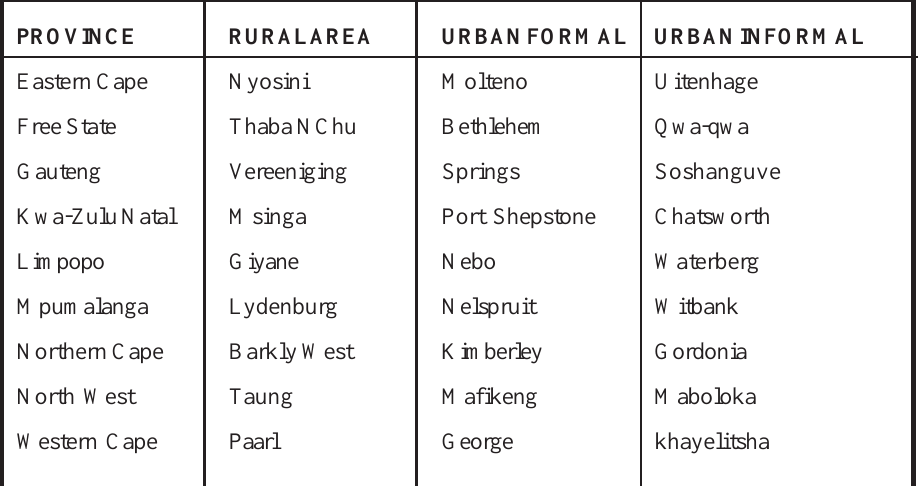
Table 1: Sampled areas representative of provinces in South